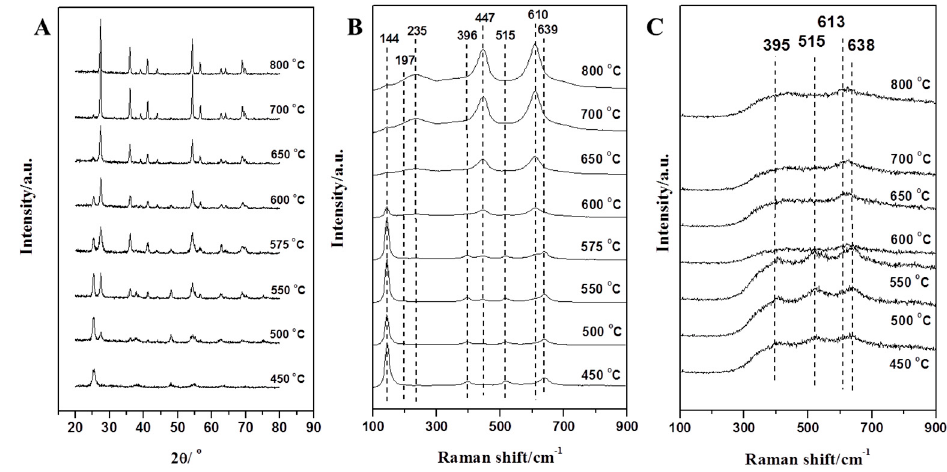
Figure 2. ( A ) XRD pattern, ( B ) visible Raman spectra, and ( C ) UV Raman spectra of the TiO 2 nanofibers calcined in air at different temperatures. Table 1. Crystallographic composition (%) of TiO 2 nanofibers calcined at different temperatures. Temperature